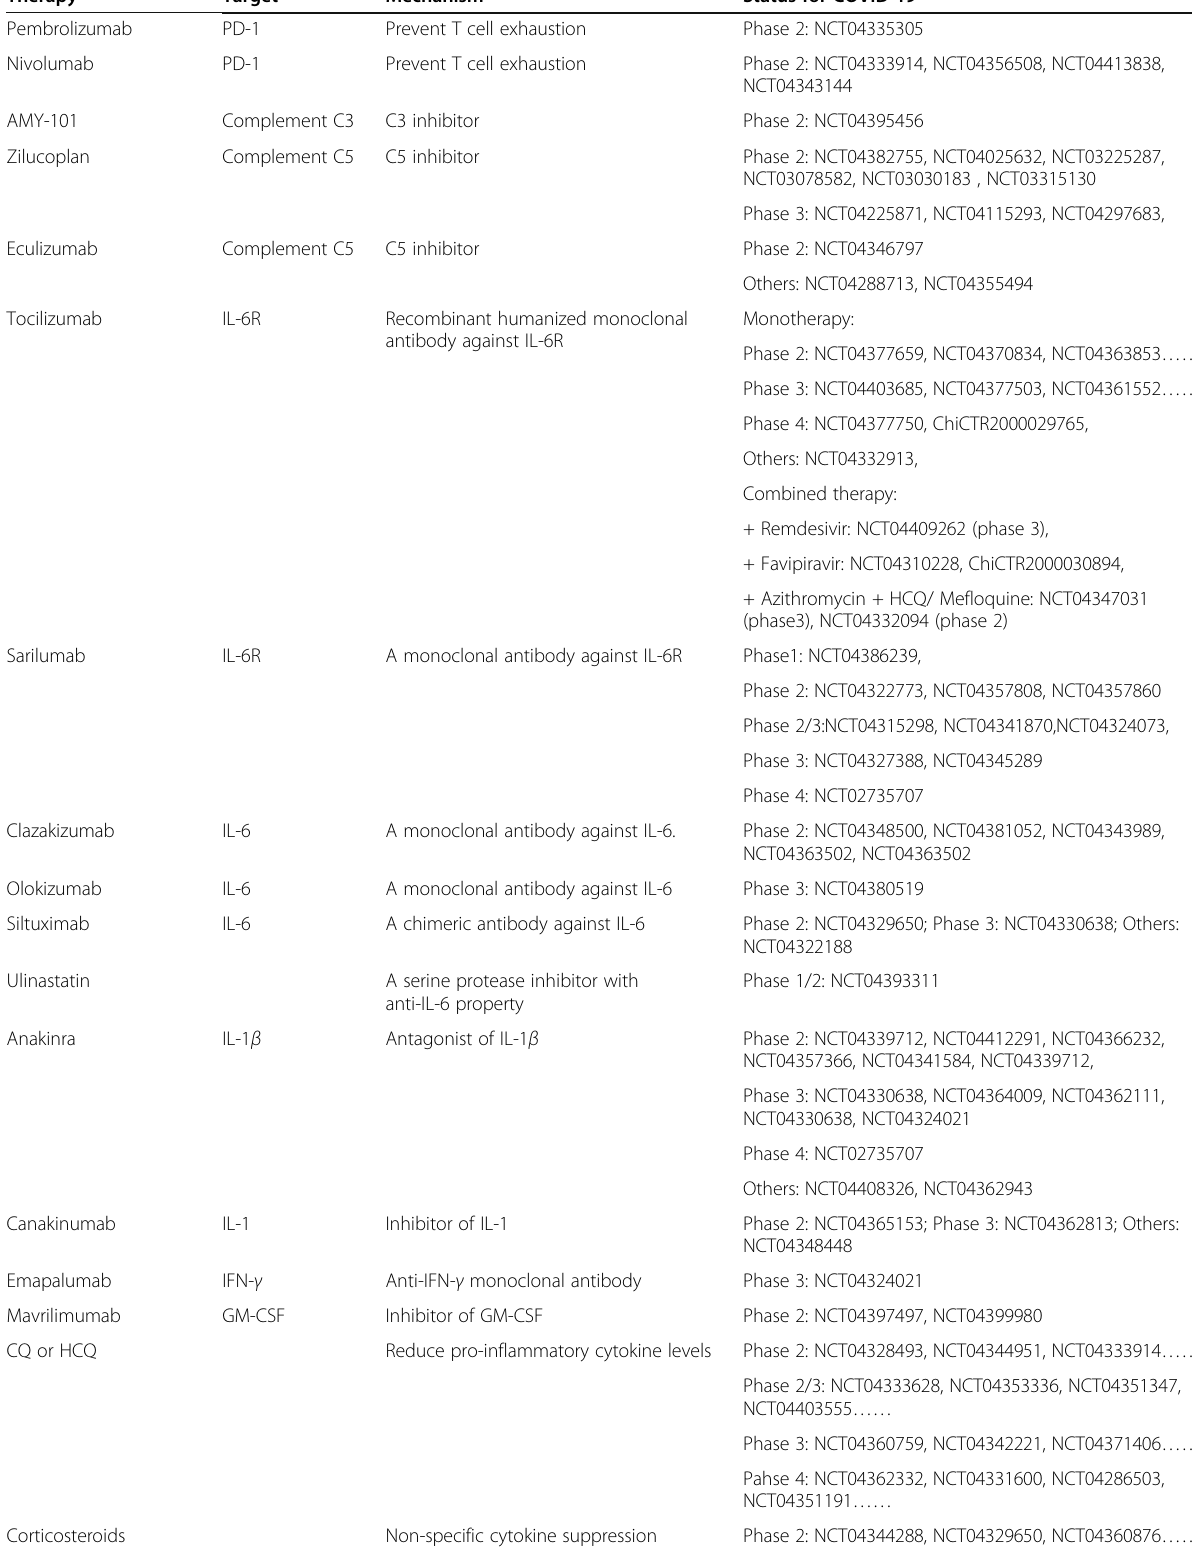
Table 2 Ongoing clinical trials of immune-related therapies for